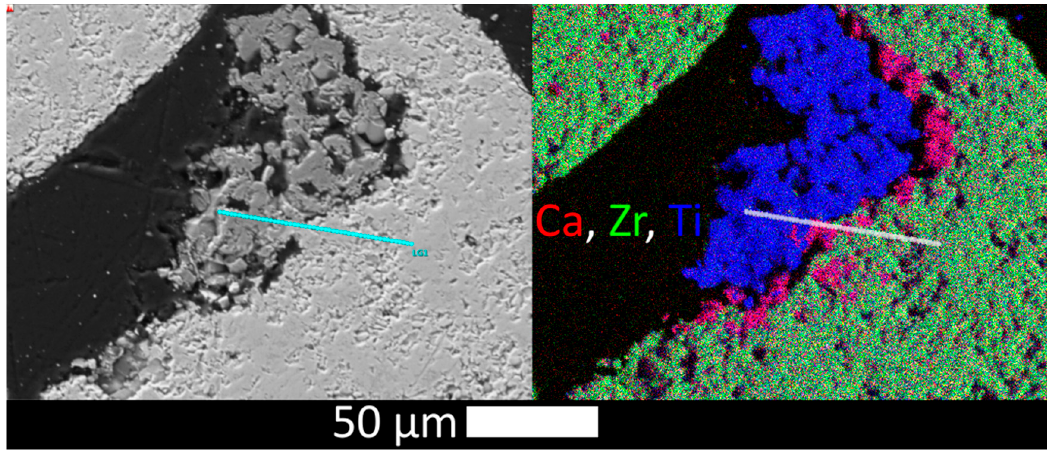
Figure 11. Grain boundary in zirconolite after leaching in 0.25 M HCl at 85 °C. Left : BSE image, right : element map.